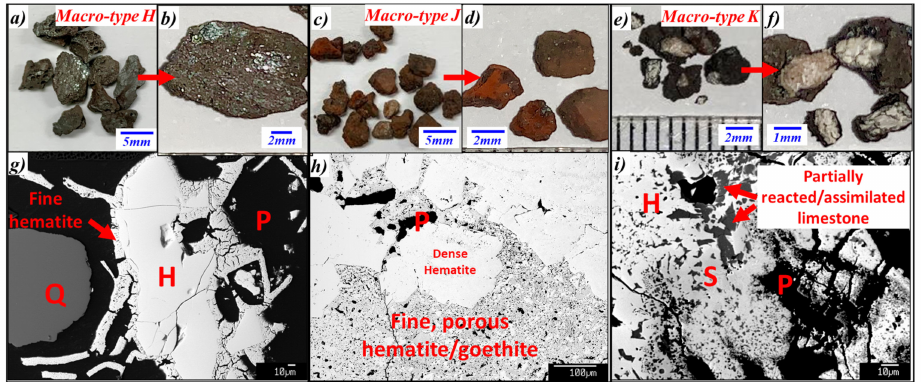
Figure 11. Macro-features of other return samples: ( a , b ) Macro-Type H; ( c , d ) Macro-Type J; ( e , f ) Macro-Type K; and their respective typical microstructures: ( g ) Macro-Type H; ( h ) Macro-Type J and ( i ) Macro-Type K, H = Hematite; S = SFCA solid solution; P = Pores; and Q =